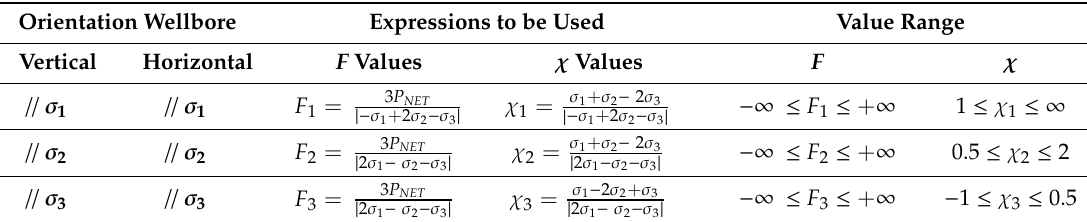
Table A1. Summary of ( F , χ ) values used for total stress